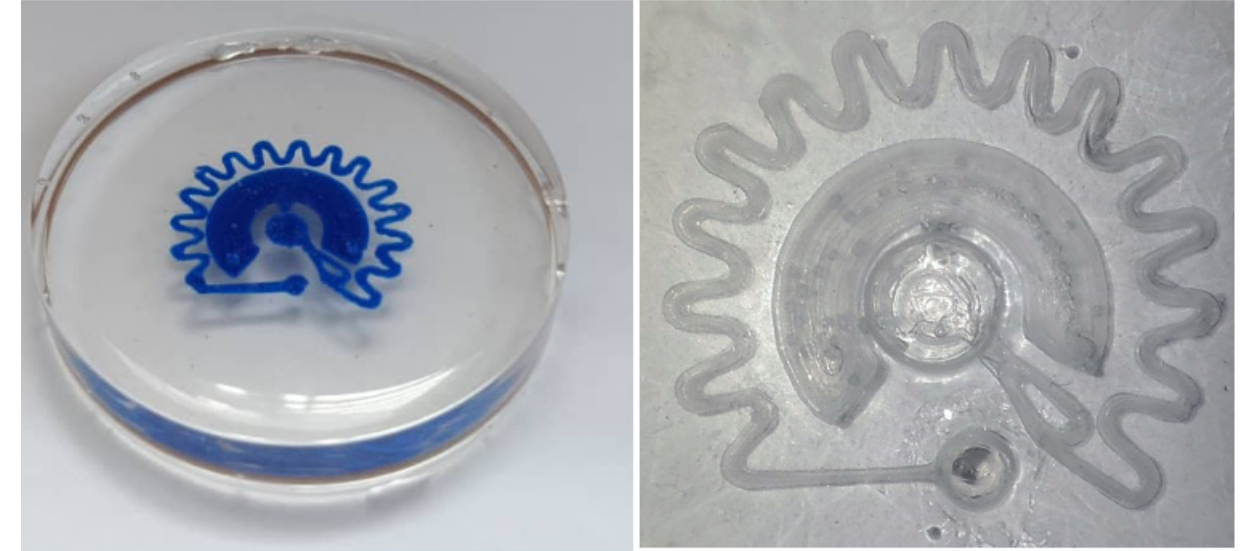
Figure 9. Schematic of the ABS printed mold-removal fabrication method for manufacturing micro- fl uidic devices showed photo of cure PDMS with ABS printed mold and sacri fi cial template ABS crofluidic devices showed photo of cure PDMS with ABS printed mold and sacrificial template ABS printed mold removal create cavity microchannel. printed mold removal create cavity